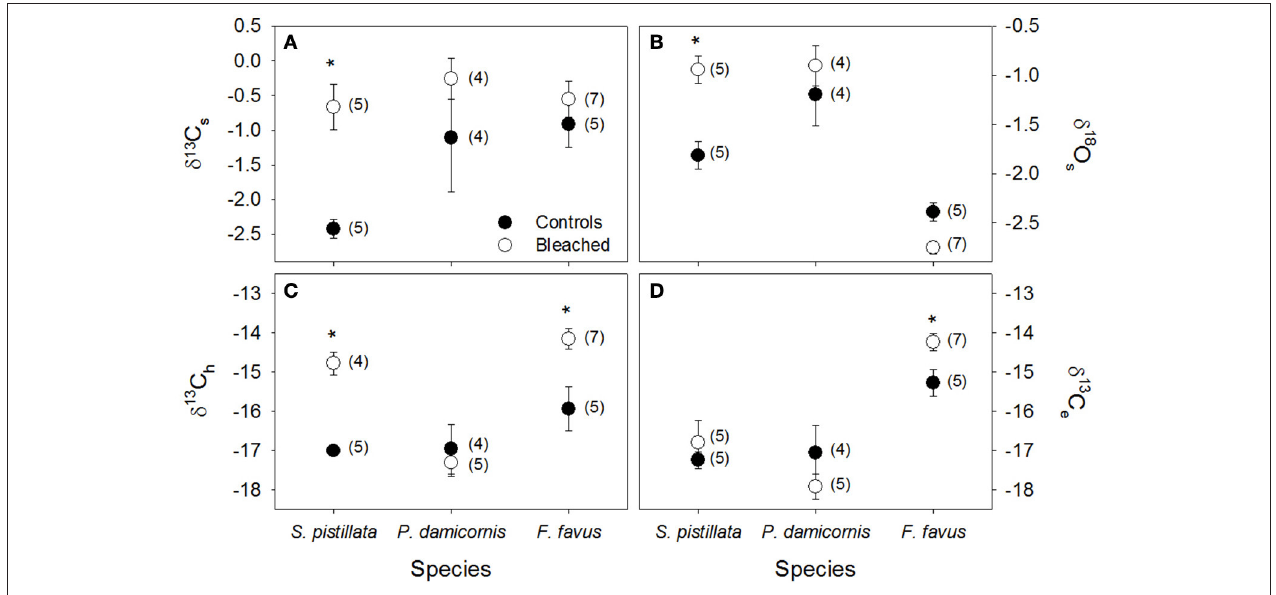
FIGURE 3 | Average stable isotopes in control (black circles) and bleached (white circles) coral skeleton (s), host tissue (h) and algal endosymbiont (e) fractions. (A) δ 13 C s , (B) δ 18 O s , (C) δ 13 C h , and (D) δ 13 C e in Stylophora pistillata , Pocillopora damicornis , and Favia favus corals. All data are reported in permil ( h ) relative to V-PDB. Averages are plotted ± 1 standard error, sample sizes for each average are indicated in brackets, and significant differences between average control and bleached values within each species are indicated with a *. Corresponding ANOVA results are given in Table 3 .